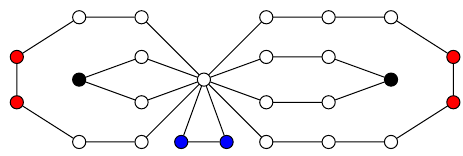
Figure 2. A bouquet of cycles B ∈ B 2,2,1 containing the cycles C 6 , C 4 , C 9 , C 7 and C 3 .